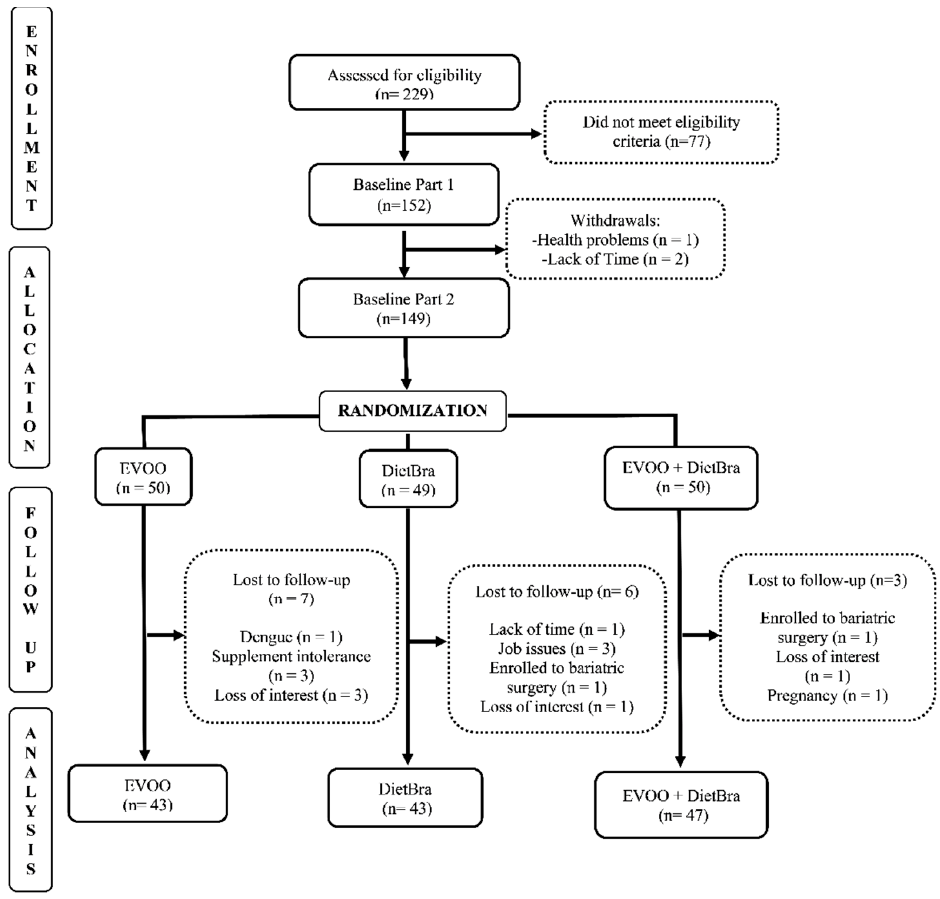
Figure 1. CONSORT diagram for study recruitment.